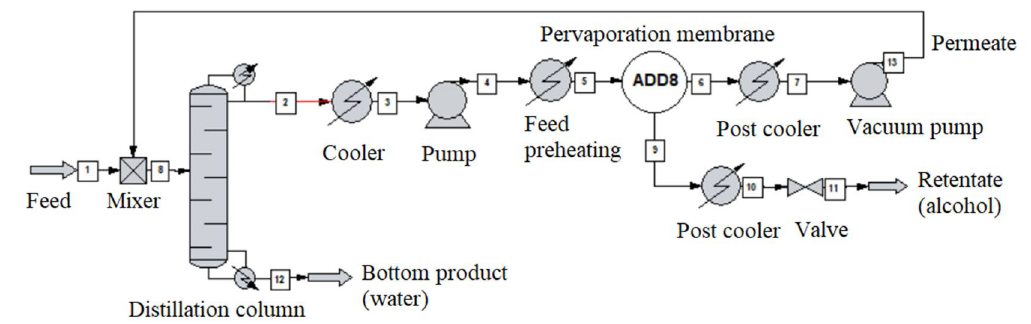
Figure 8. Flowsheet of hybrid distillation-hydrophilic pervaporation method.